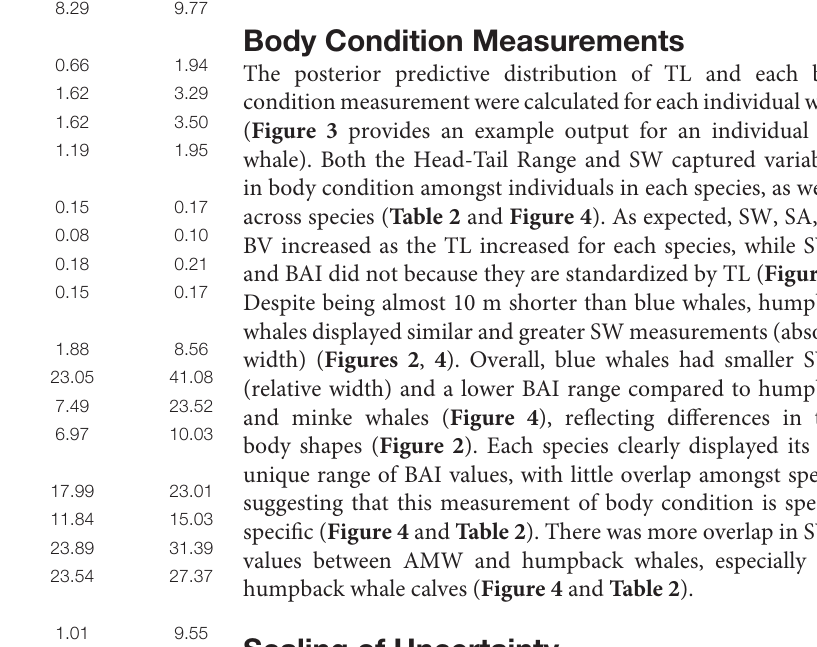
Correlation Each standardized body condition measurement (SW std , BAI, BCI SA , and BCI BV ) was highly correlated across